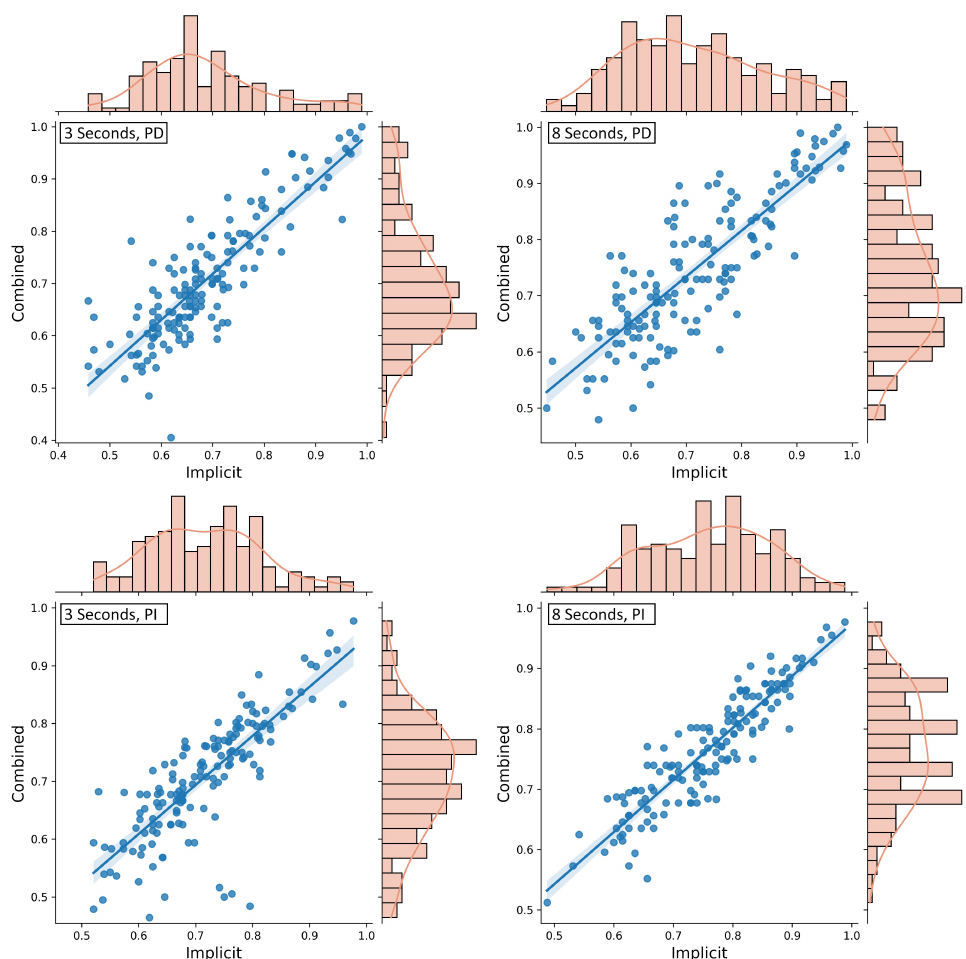
Figure 3. The distributions of implicit and combined feature sets represented as histograms and scatter plots including a visualization of the correlation. The 3 s windows are displayed on the left, and the 8 s windows are displayed on the right. PD = Person-dependent; PI =